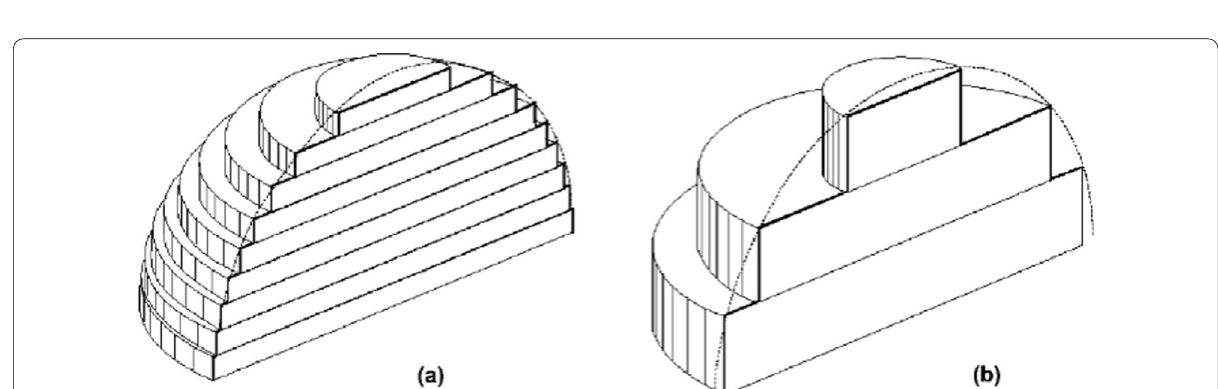
Fig. 4 Comparison of staircase inaccuracies because of thin and thick layers. a Thin layers better approximate the surfaces; b thick build layers poorly approximate complex surfaces. The figure demonstrates how the staircase inaccuracies in thicker layers are considerably higher. In contrast, the use of thin layers helps to make the surfaces cleaner and more detailed. Source: Sabourin, 1996; Sabourin et al. (1997), Reference